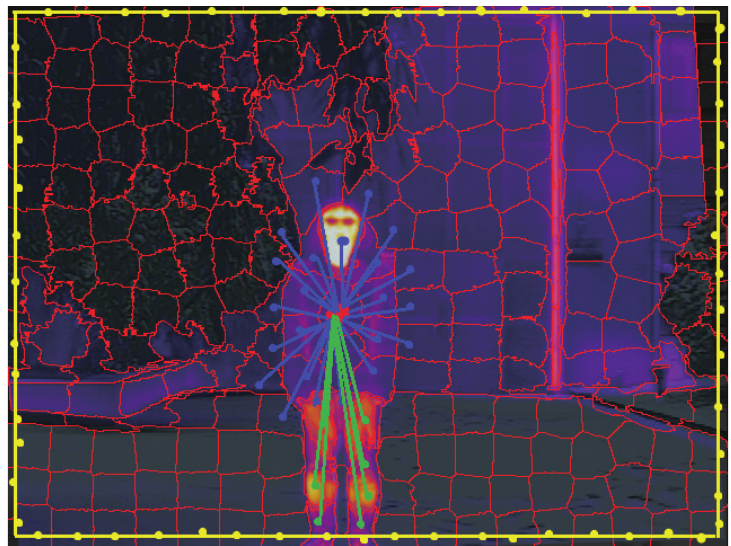
Figure 2. The general view of the static-adaptive graph on the multi-modality fusion image. The blue edges are obtained by the traditional static graph. The green edges are obtained by our adaptive graph learning